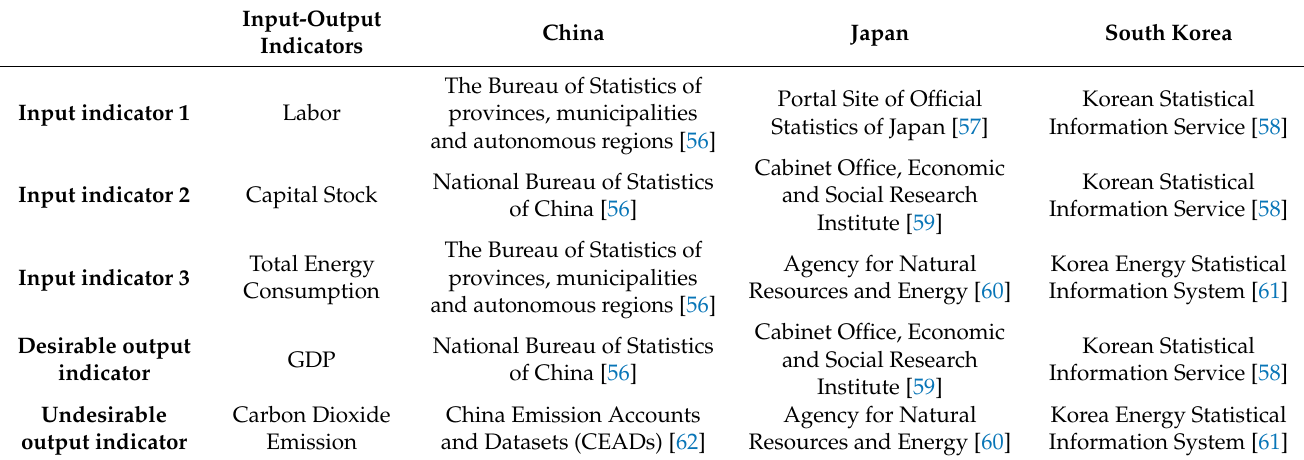
Table 3. The data sources of input-output